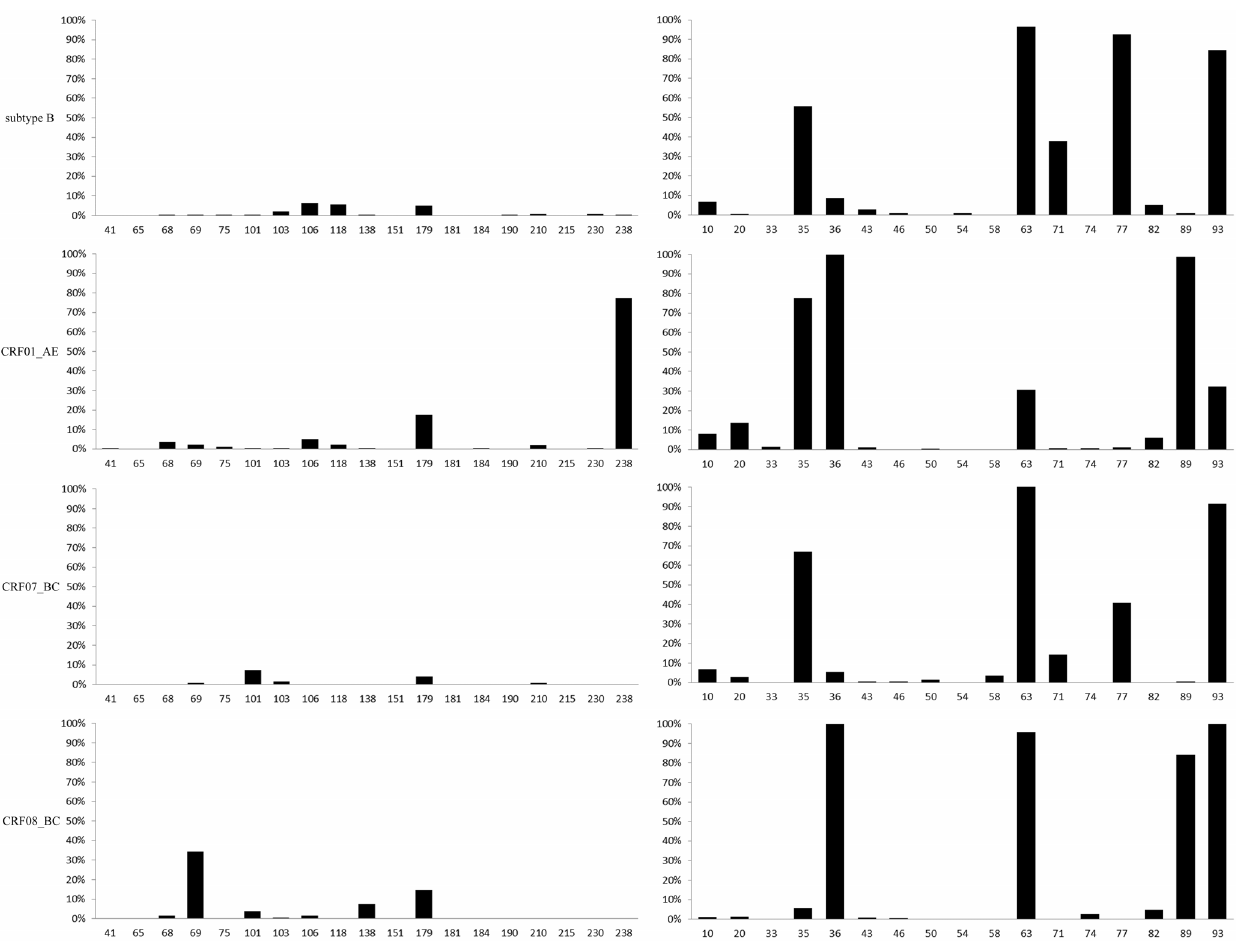
Figure 3. Subtype-specific drug resistance mutation sites analysis based on ART sensitive sequences. Note: left part based on RT region and right part based on protease region, horizontal numbers indicate drug resistance mutation sites with significant difference among subtypes(chi- square or fisher’s exact test, p , 0.05), vertical percentage indicate the proportion of mutated amino acids differ from the subtype B consensus sequence.